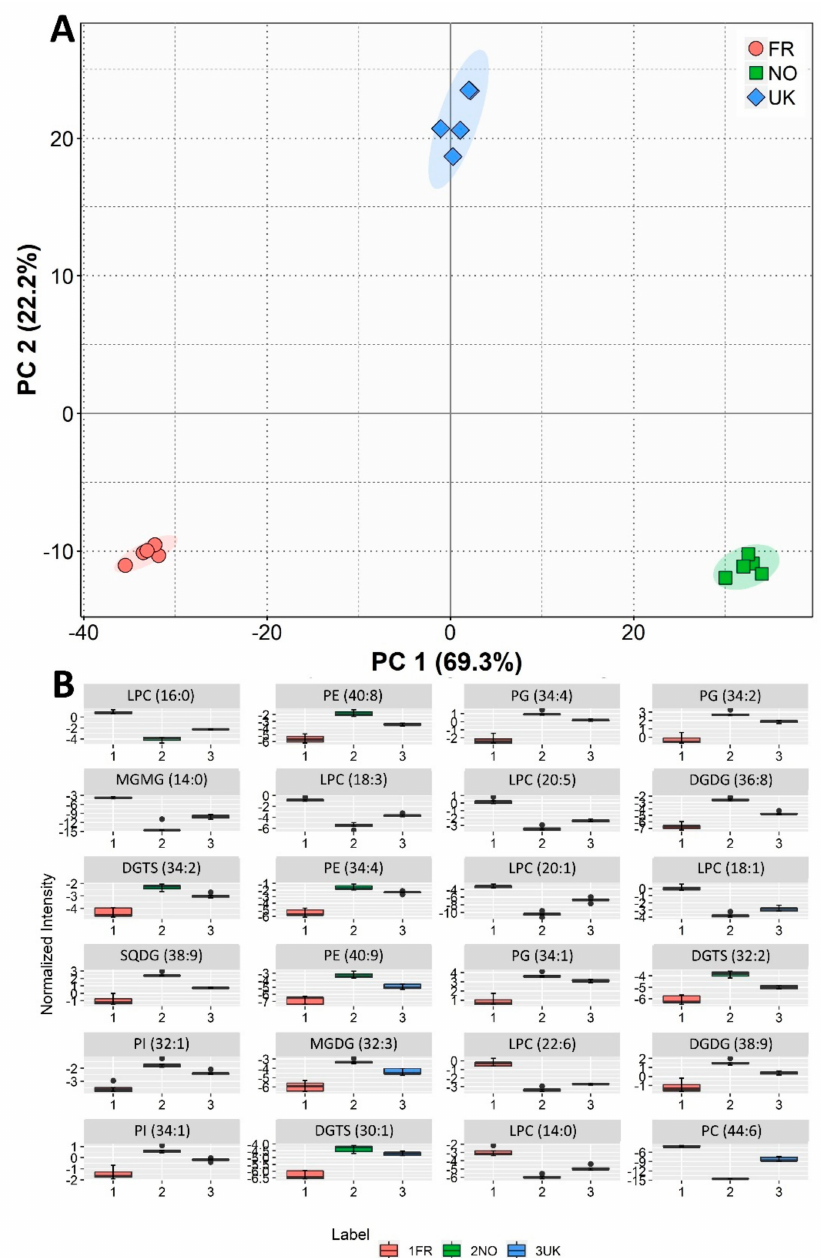
Figure 4. Sample origin discrimination with regard to polar lipid molecular content. ( A ) Principal component analysis (PCA) score plot of the lipid profiles in terms of the molecular polar lipid species present in samples of Saccharina latissima from di ff erent origins (FR—France, NO—Norway, UK—United Kingdom). ( B ) Box plots of the top 24 contributors to the first dimension of the PCA plot. Labels of the species are according to the notation AAAA (xx:i) (AAAA = lipid class; xx = total of carbon atoms in fatty acid; i = number of